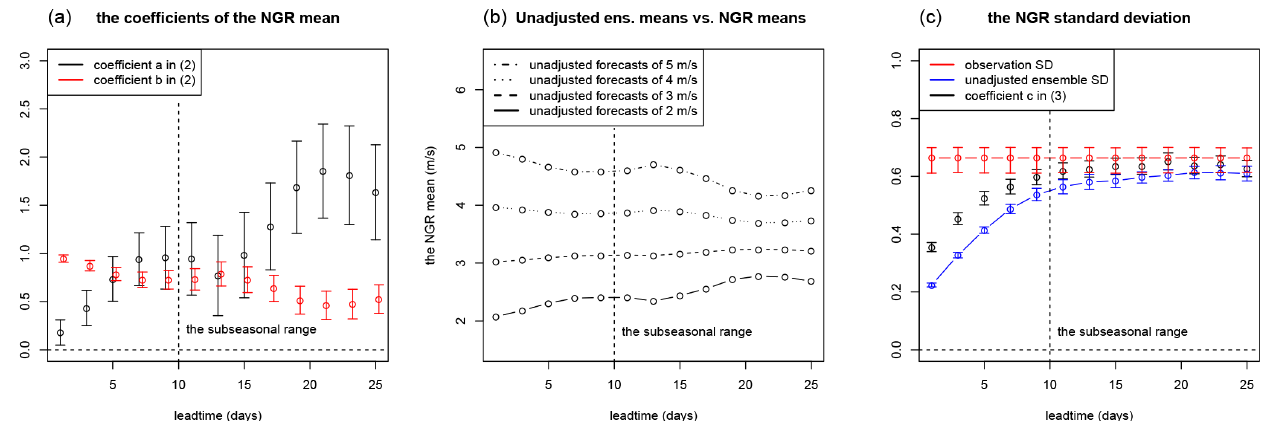
Figure 2. The fitted coefficients for NGR as the function of lead time: (a) the mean (Eq. 2), and (b) how the ensemble mean of the unadjusted or raw forecast is then modified by the NGR. (c) The standard deviation (Eq. 3, using only the intercept term) shown along with the ensemble standard deviation of the unadjusted forecasts and the standard deviation of observations (based on ERA-Interim). To help interpreting the standard deviation values, the logarithm was not used in Eq. (3). The training set, odd winters during 1997–2017, was